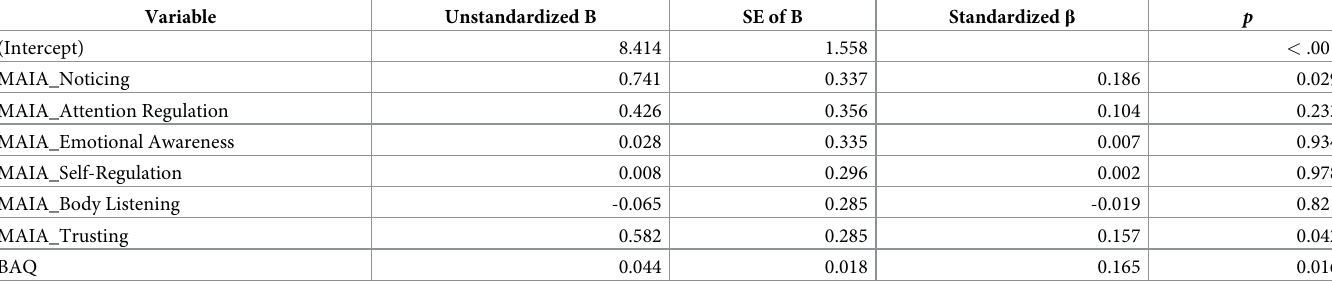
Table 3. Results of multiple linear regression analysis with positive affect as criterion